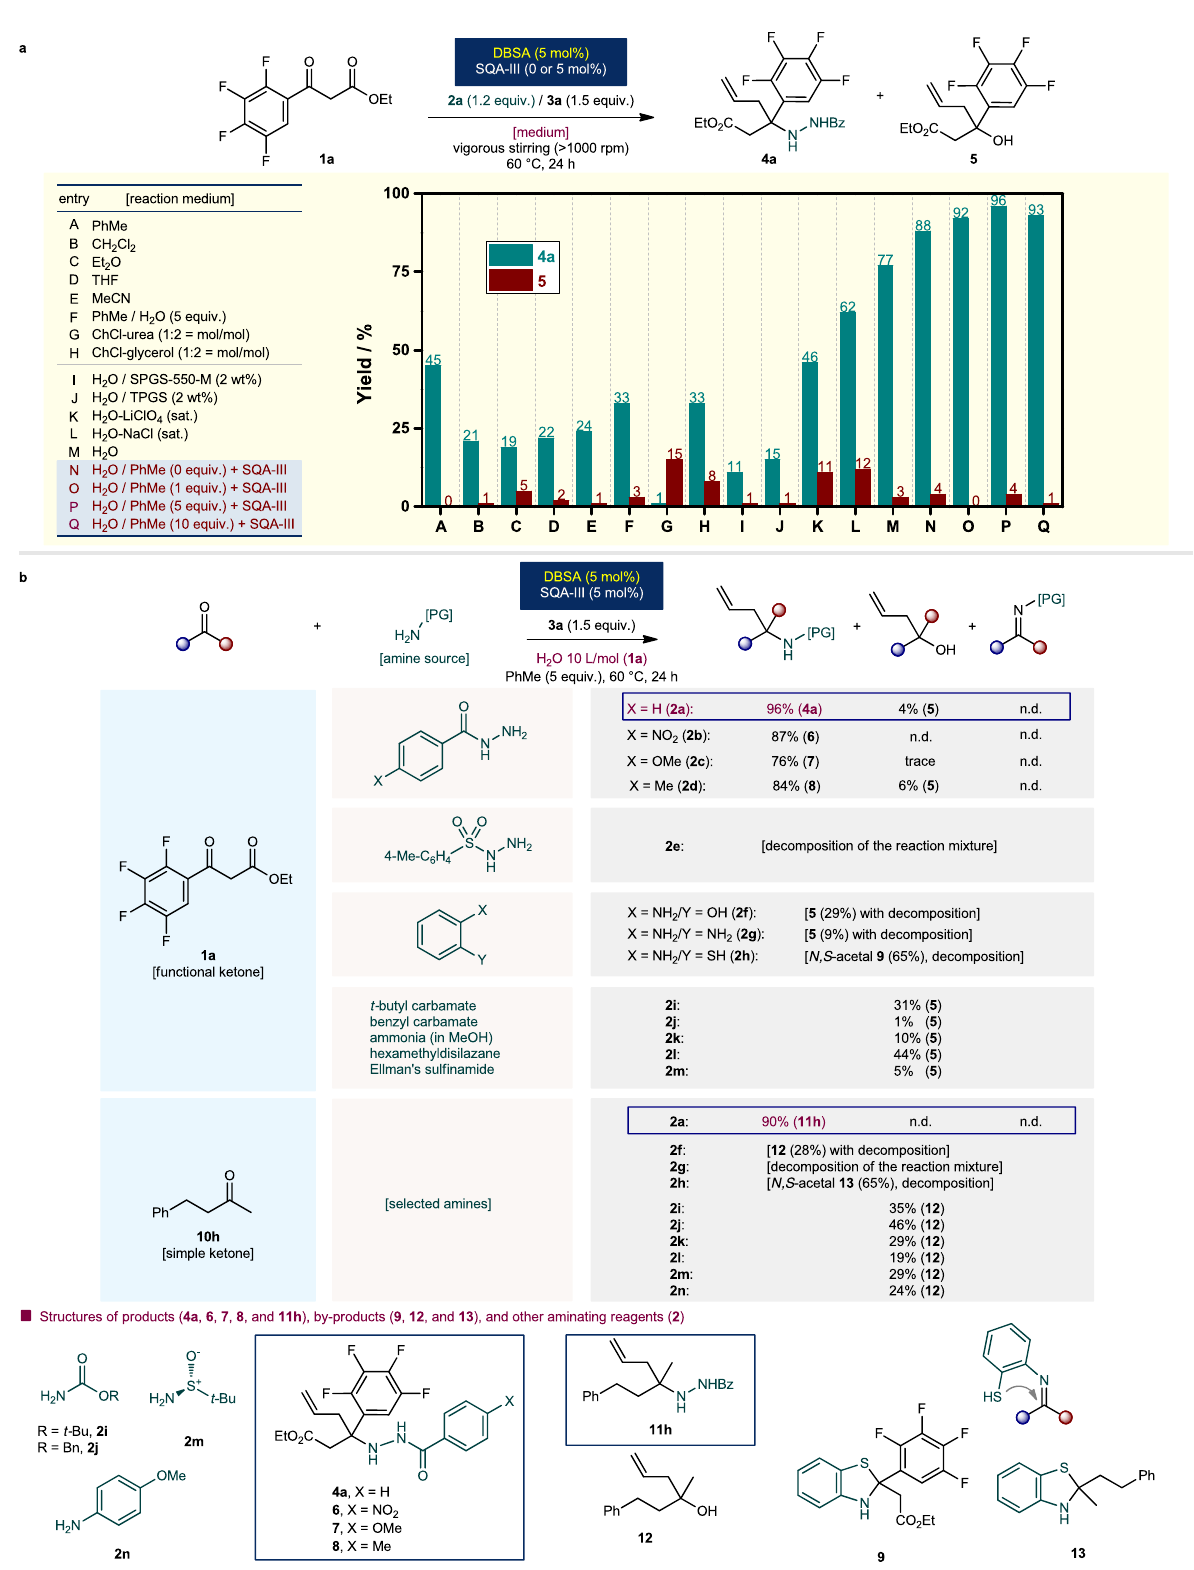
Fig. 2 Detailed study on the reaction media and amine sources. a Effect of reaction medium. b Detailed study on the amine source. a Conditions: Reactions were performed with ketone (0.2 mmol), amine source (1.2 equiv.), allylboronic acid pinacol ester 3a (1.5 equiv.) and set of catalysts (5.0 mol%) with medium (2.0 mL: 10 L/mol ( 1a or 10h )) at 60 °C for 24 h. b Yields were determined by 1 H NMR analysis using 1,3,5-trimethoxybenzene as internal standard. c n.d. = not detected. Bn = benzyl; t -Bu = tert -butyl; Bz = benzoyl; Et = ethyl; Me = methyl; Ph =